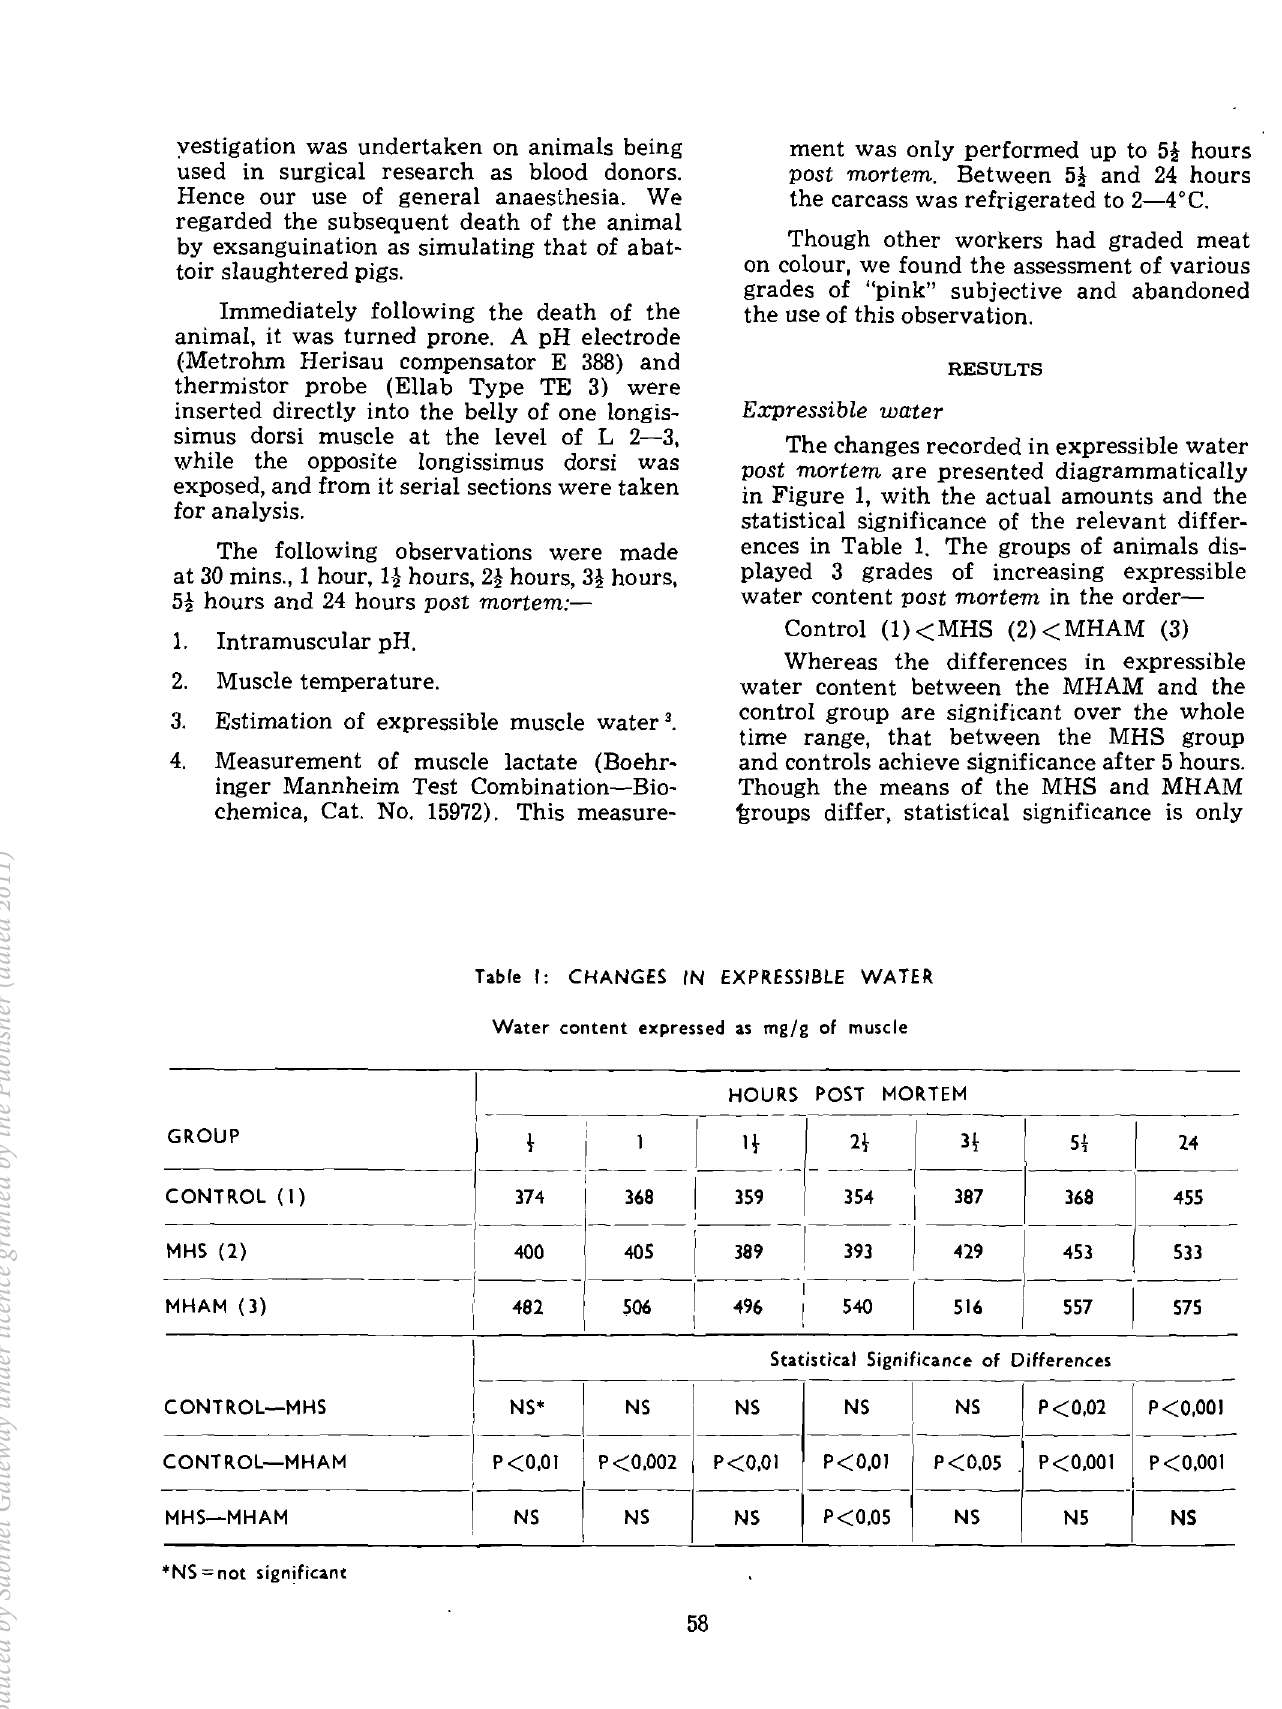
Table r: CHANGES IN EXPRESSIBLE